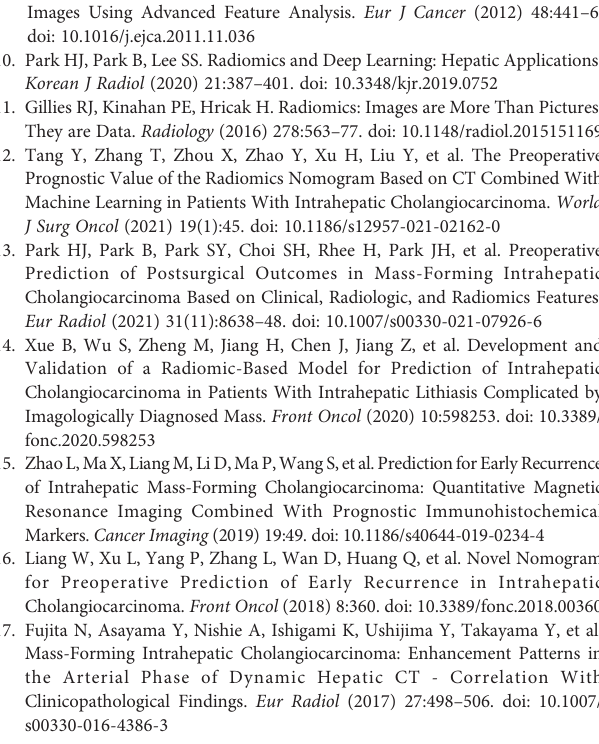
Supplementary Figure 1 | The optimal cut-off value of male PMI was 8.47 (A) , and that of female PMI 5.03 (B) . Supplementary Figure 2 | The optimal cut-off value of PLR was 147.93 (A – C) , NLR was2.53 (D – F) , and LMR was 2.92 (G – I) . Supplementary Figure 3 | The global Schoenfeld test and individual Schoenfeld of fi ve radiomics features in the training set. Supplementary Figure 4 | The global Schoenfeld test and individual Schoenfeld of fi ve factors in the clinical-radiomics